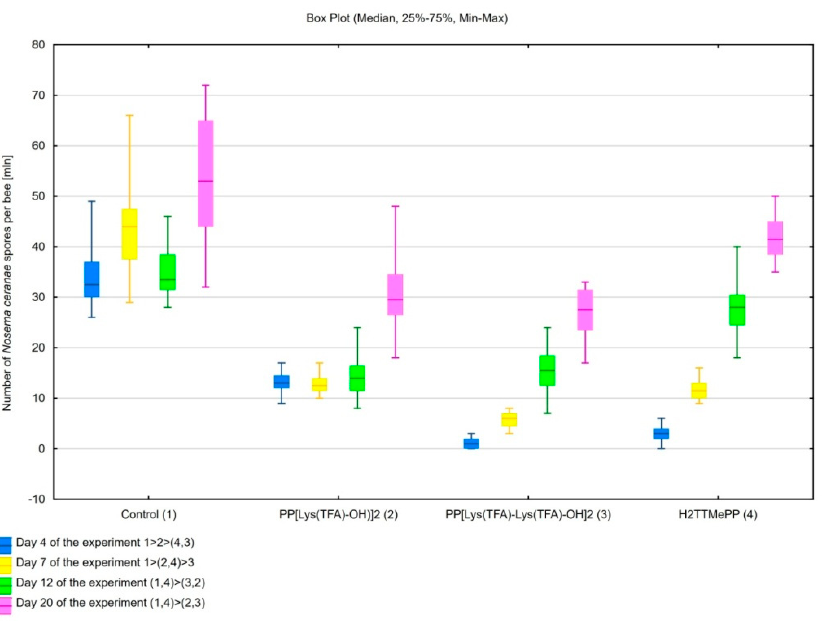
Figure 2. Impact of incubation of Nosema ceranae microsporidia with porphyrins on the number of spores in honeybees. The differences between the groups are shown in the figure legend ( p < 0.01; Kruskal-Wallis test).